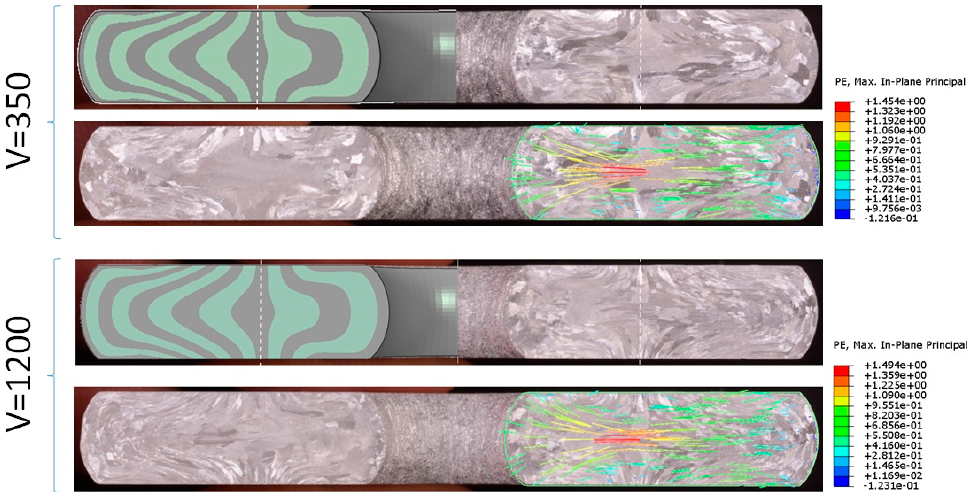
Figure 14. Comparison between predicted and experimental ring neutral radius and flow patterns for specimens R3 ( top ) and R4 ( bottom ), which represent the effect of strain rate, on unlubricated rings at 350 °C .